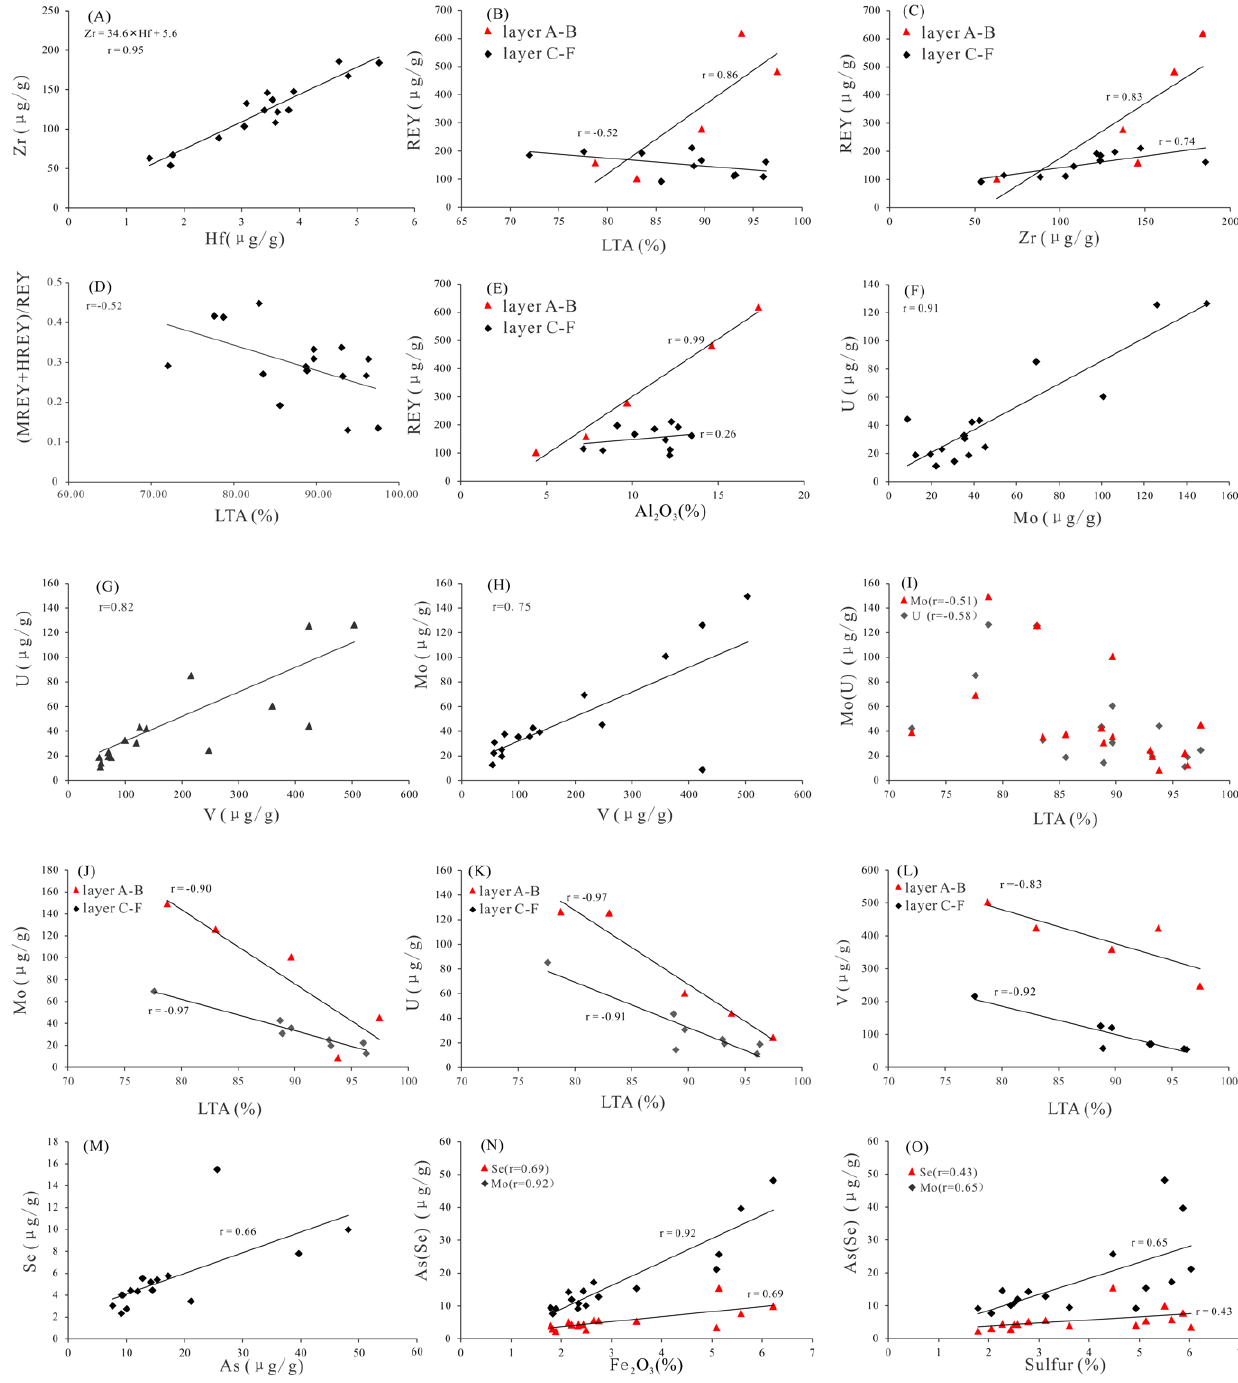
Figure 12. Correlation among selected elements and LTA: ( A ) plot of Zr vs. Hf; ( B ) plot of REY vs. LTA; ( C ) plot of REY vs. Zr; ( D ) plot of (MREY + HREY)/REY vs. LTA; ( E ) plot of REY vs. Al 2 O 3 ; ( F ) plot of U vs. Mo; ( G ) plot of U vs. V; ( H ) plot of Mo vs. V; ( I ) plot of Mo(U) vs. LTA; ( J ) plot of Mo vs. LTA; ( K ) plot of U vs. LTA; ( L ) plot of V vs. LTA; ( M ) plot of Se vs. As; ( N ) plot of As(Se) vs. Fe 2 O 3 ; and ( O ) plot of As(Se) vs. Sulfur.